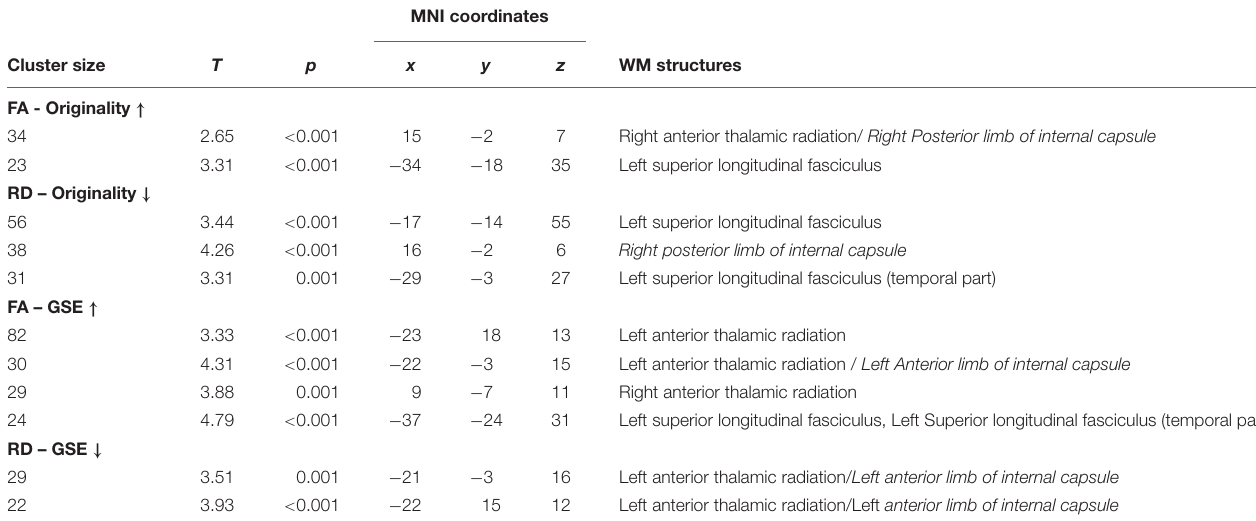
TABLE 6 | Results of voxelwise correlation analyses between longitudinal changes in FA and RD maps and concomitant changes in behavioral tests ( p < 0.005 uncorrected). MNI